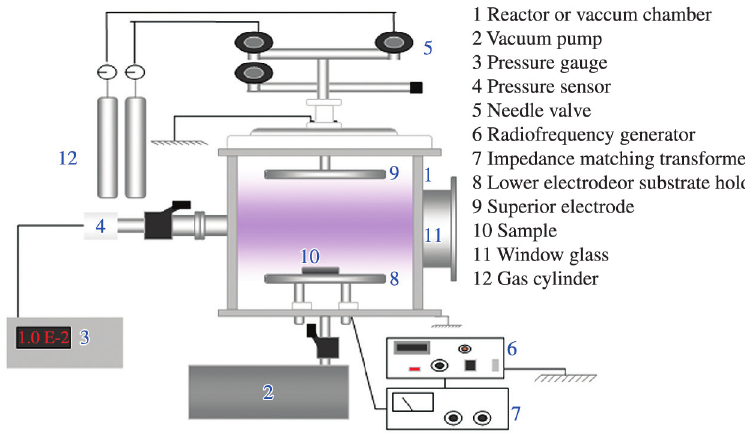
Figure 1. Experimental setup used for film deposition and substrate cleaning by